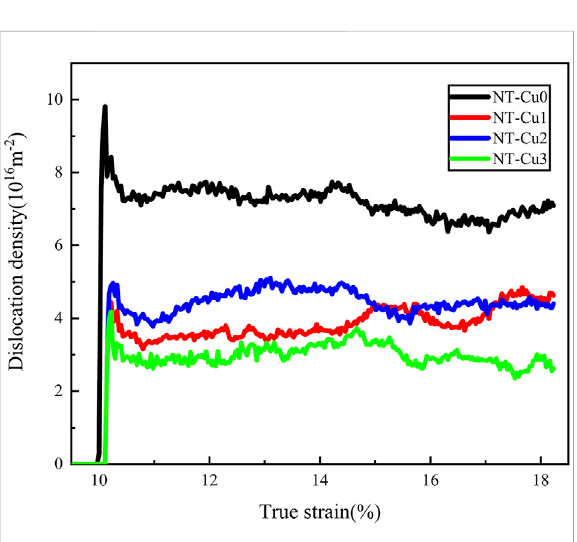
FIGURE 6 Variation of dislocation density with tensile true strain in the inner cores of samples (There is no dislocation in the inner cores, until tensile true strain researches about